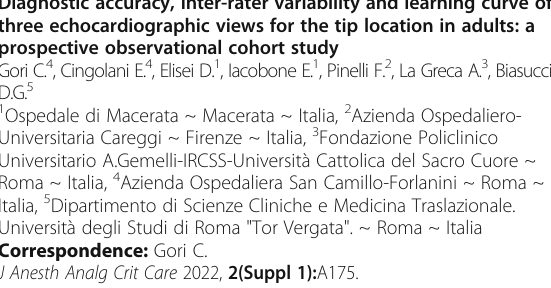
A175. Diagnostic accuracy, inter-rater variability and learning curve of three echocardiographic views for the tip location in adults: a prospective observational cohort